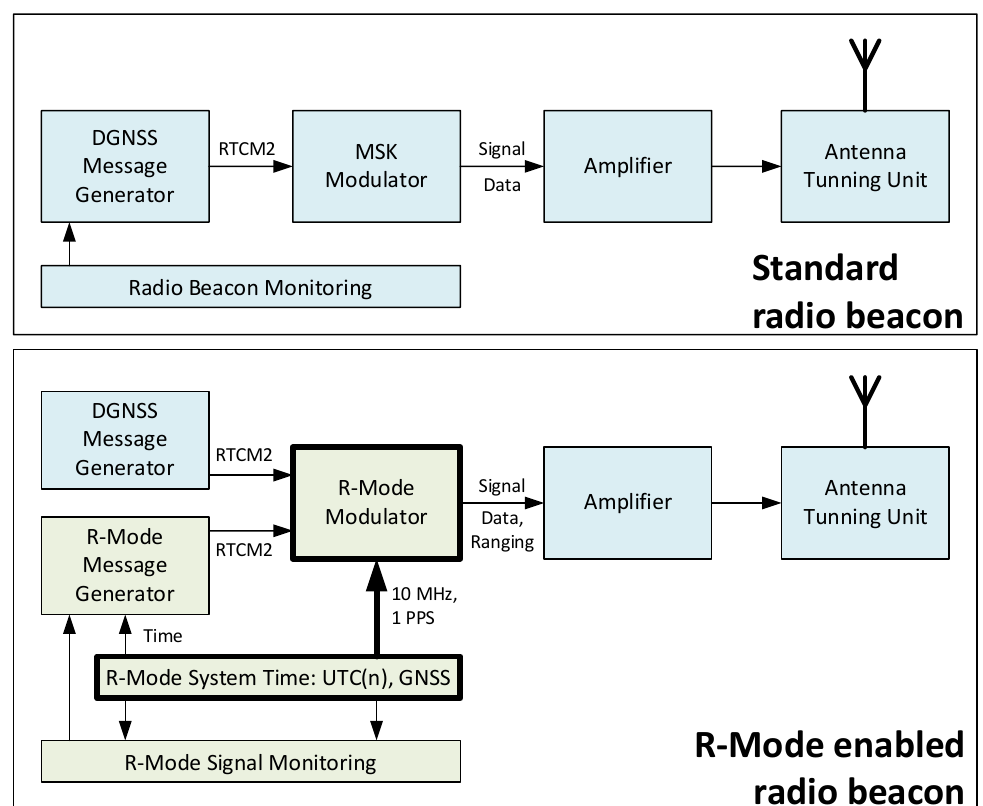
Figure 4. Difference between a standard MF radio beacon architecture ( above ) and the R-Mode- enabled radio beacon ( below